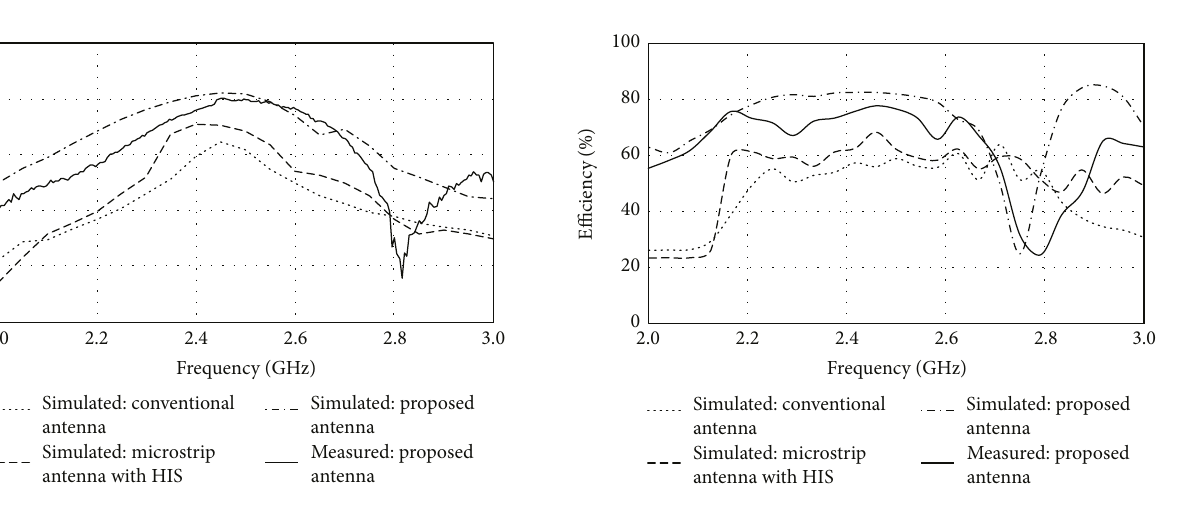
Figure 17: The simulated and measured radiation e ffi ciency under various antenna